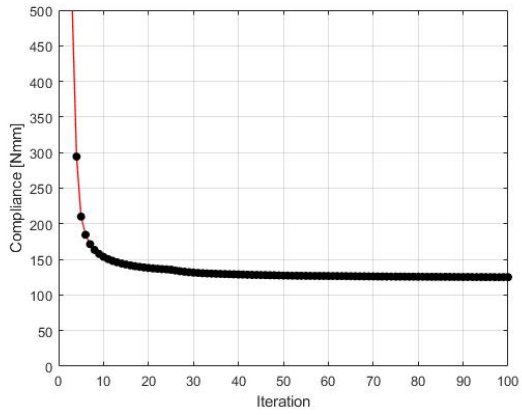
Figure 14. The compliance history for the test structure 2. Minimal value: 125.07 Nmm. Black dots on the red line represent the compliance values for subsequent iterations.